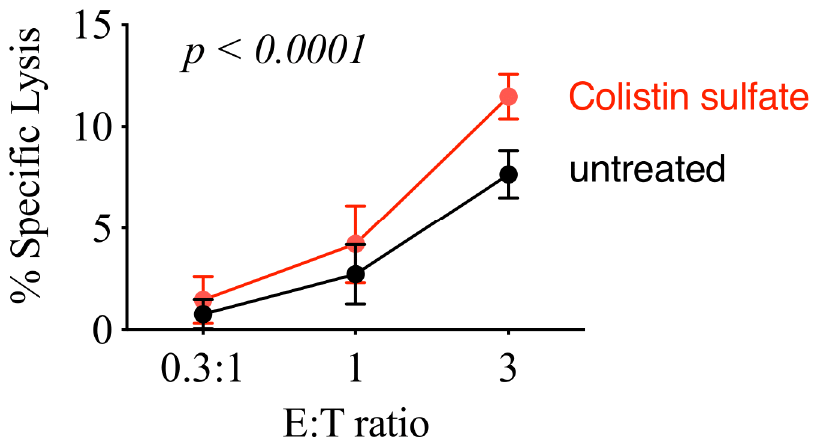
Figure 9. Colistin sulfate enhances the killing activity of primary human NK cells. Human NK cells isolated from PBMCs from healthy donors were mixed with K562-NL cells and were seeded into a 96-well V bottom plate at increasing E:T ratios, with 10,000 K562-NL cells per well, and treated with 10 μ M of colistin for 5-h at 37 °C. After incubation, the supernatant was collected and transferred to 96-well black plates. The Biotek Synergy microplate reader (Winooski, WI, USA) was used to dispense CTZ and read luminescence. Percent specific lysis is shown. Mean +/ − SD of three technical replicates, the experi- ment was repeated three times. Statistical analysis was conducted with two-way